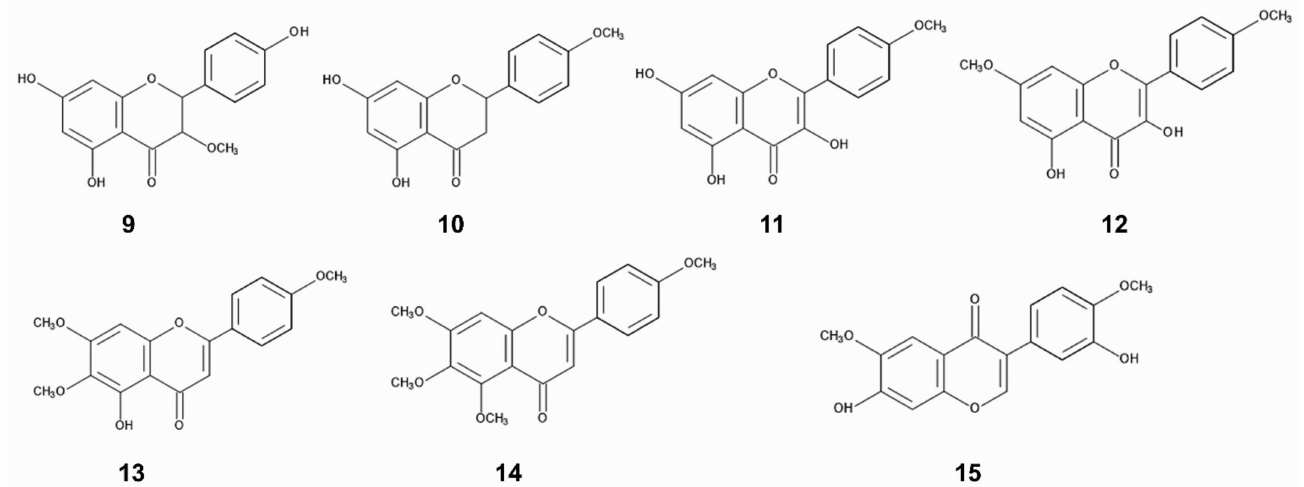
Figure 3. Flavonoids; 9: dihydrokaempferol-3-methoxy ether, 10: isosakuranetin, 11: kaempferide- 4’-methoxy ether, 12: 3,5-dihy-droxy-7,4’-dimethoxyflavone, 13: acutellerin-4’,6,7-trimethy ether, 14: 4’,5,6,7-tetramethoxyflavone, 15: odoratin. The concentration of these compounds was grater